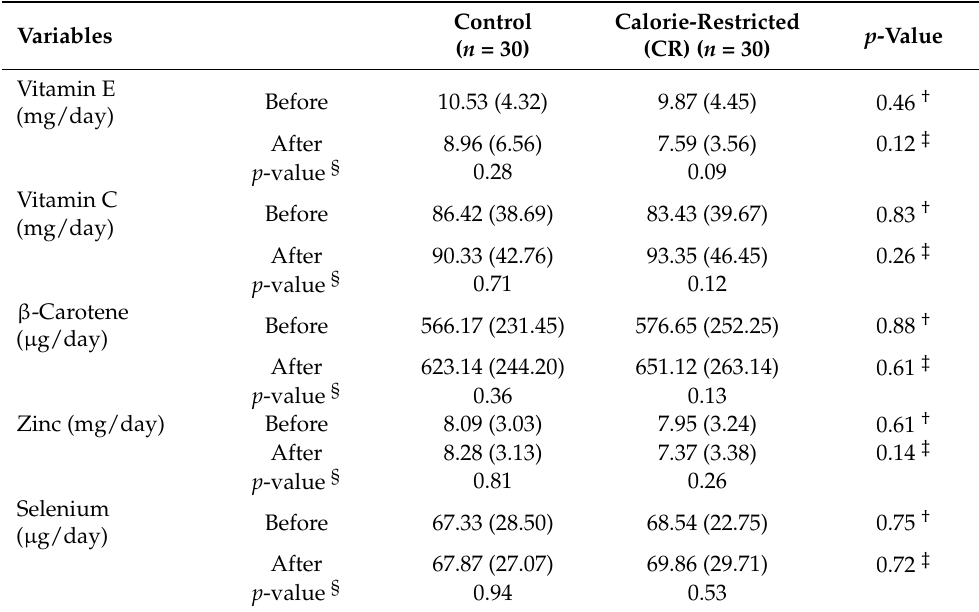
Table 2. Daily dietary intakes of known antioxidants of the study patients at baseline and after the 12-wk